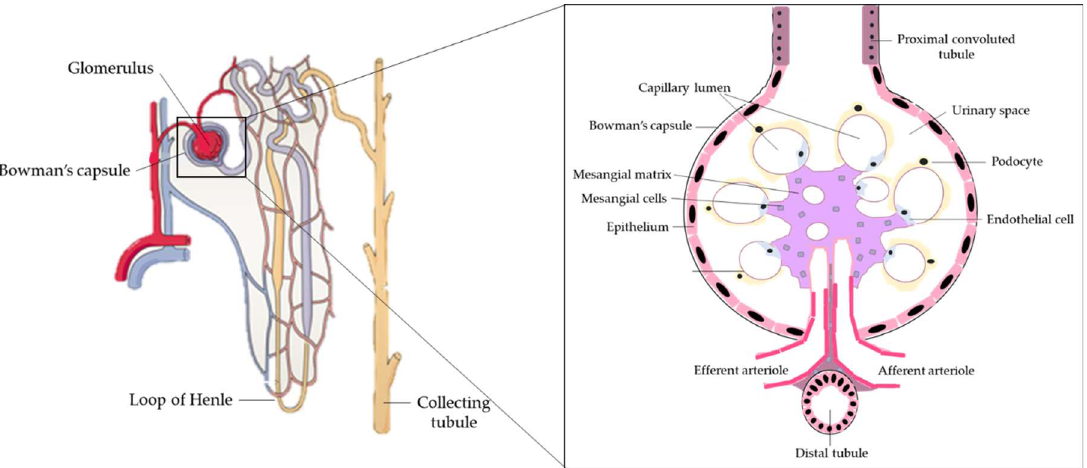
Figure 1. The structure of the glomerulus and nephron.